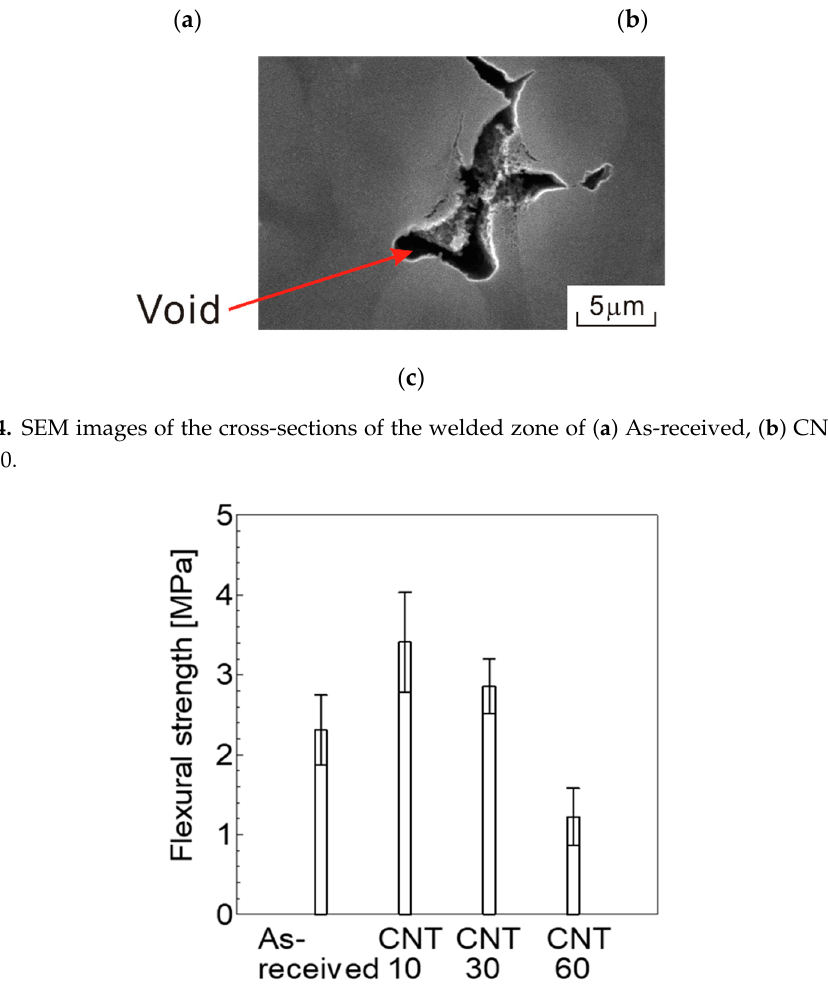
Figure 15. Flexural strengths of As ‐ received, CNT10, CNT30 and CNT60. (N = 5, mean ± S.D.).